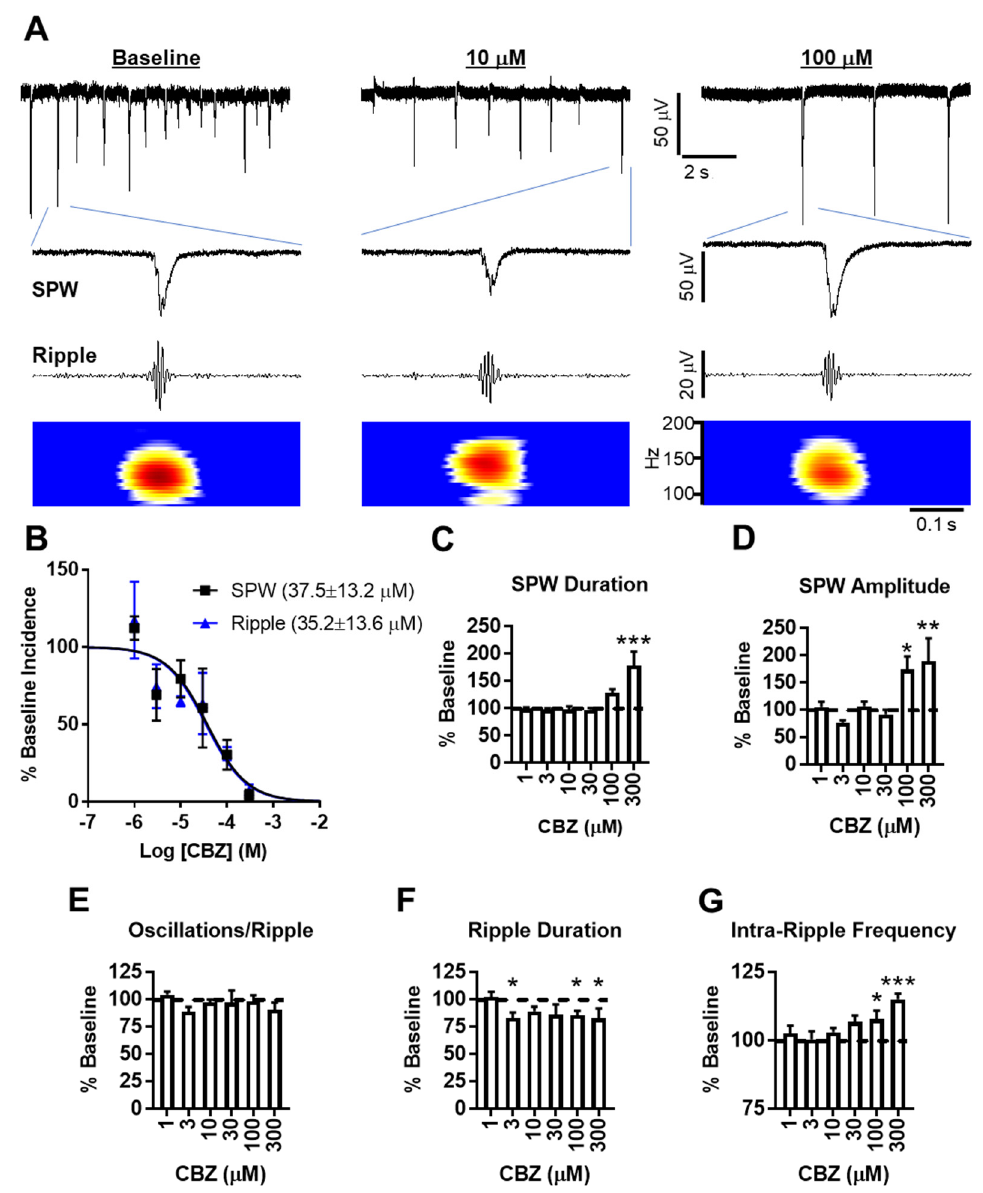
Figure 1. CBZ inhibits SPW-ripples. ( A ) Examples of SPW-ripple complexes recorded in the CA3 stratum radiatum at baseline and in the presence of CBZ. SPWs are evident in the broad band recordings (top traces), whereas ripples are fully identified via band-pass filtering and time frequency analyses (middle, bottom traces). ( B ) CBZ reduces the incidence of SPWs and ripples in a concentration-dependent manner. ( C–G ) High concentrations of CBZ significantly increase SPW duration, amplitude, and intra-ripple frequency, but CBZ has no effect on intra-ripple oscillations or duration ( n = 5 – 8 slices per CBZ concentration; * p < 0.05, ** p < 0.01, *** p < 0.001 vs. baseline).